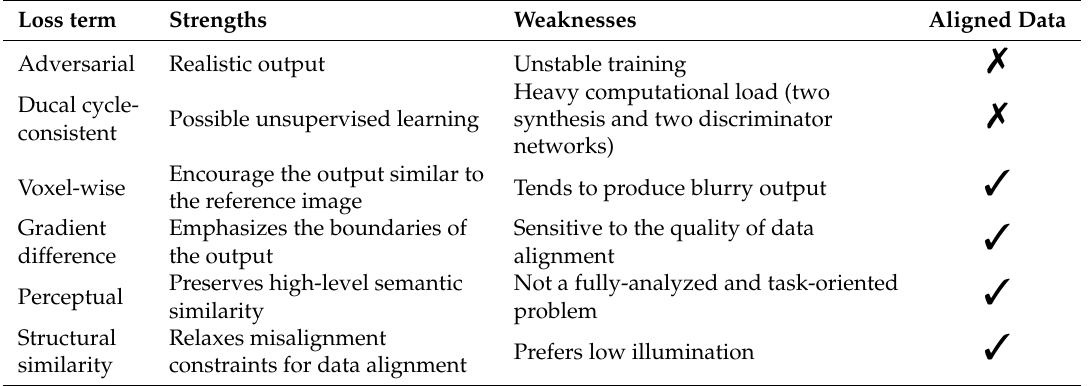
Table 3. A summary of the strengths and weaknesses of each loss term used in DC 2 Anet. In the last column, the symbols (cid:51) and (cid:55) denote whether the loss term requires aligned training data or